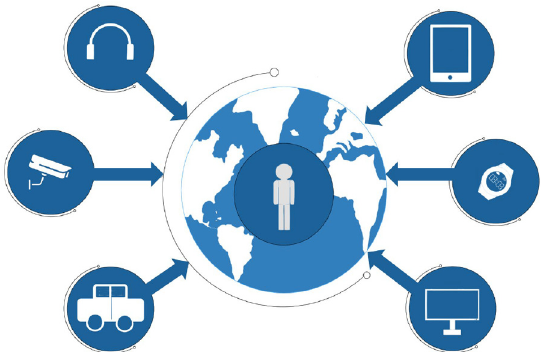
Figure 1. Schematic diagram of the